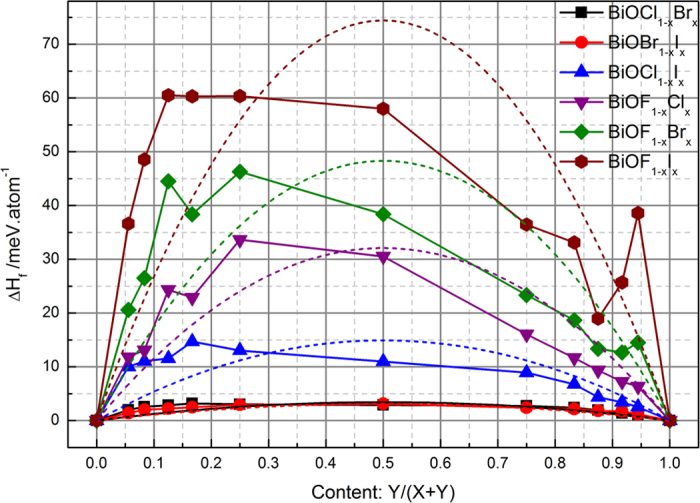
Formation enthalpy of BiOX1−xYx solid solutions as function of content content x.